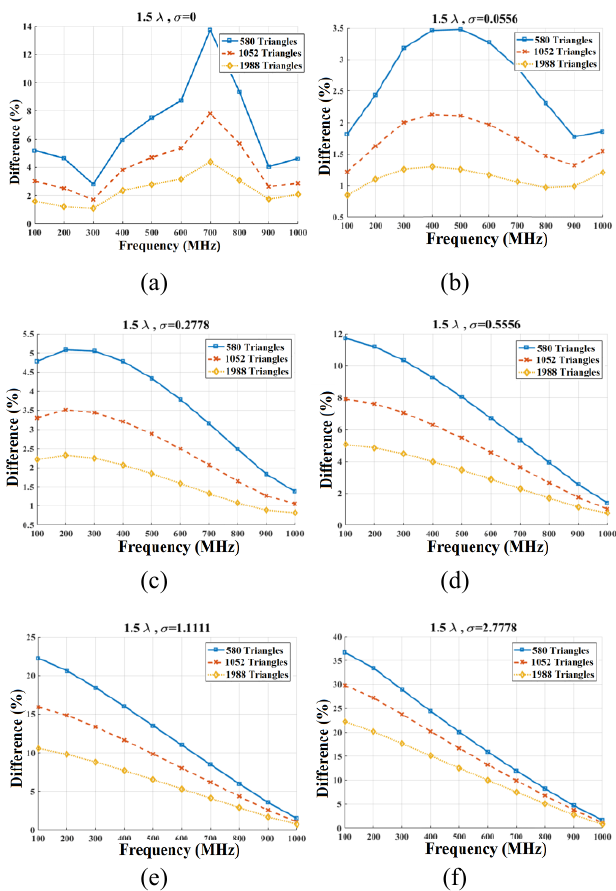
Figure 16: Field difference percentage between MoM and SFIE in wideband for (a) 𝜎 =0 (b) 𝜎 =0.0556, (c) 𝜎 =0.2778, (d) 𝜎 =0.5556, (e) 𝜎 =1.1111, (f) 𝜎